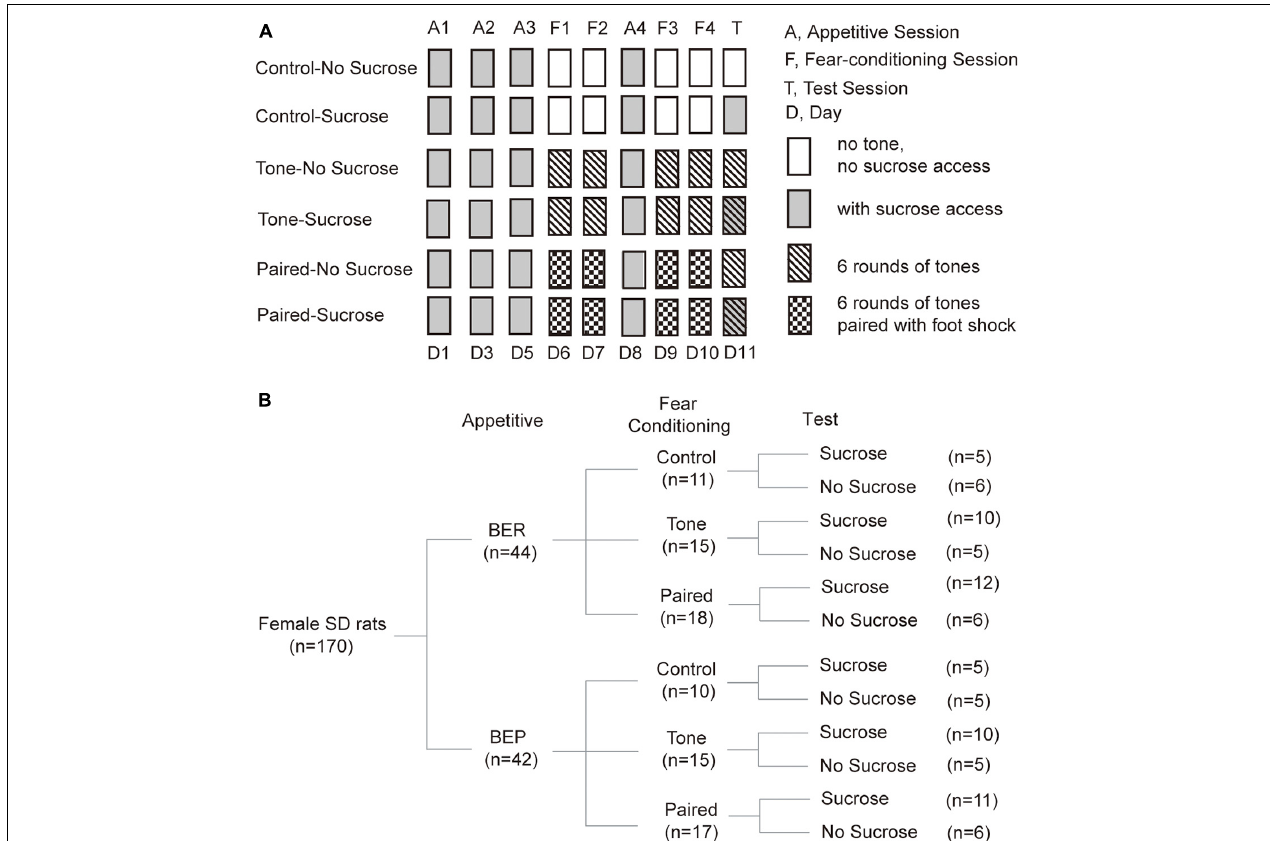
FIGURE 1 | Diagram of treatments and groups in the Fear Conditioning test. (A) Diagram of fear conditioning test procedures. (B) Number of animals in each group at each step during the fear conditioning